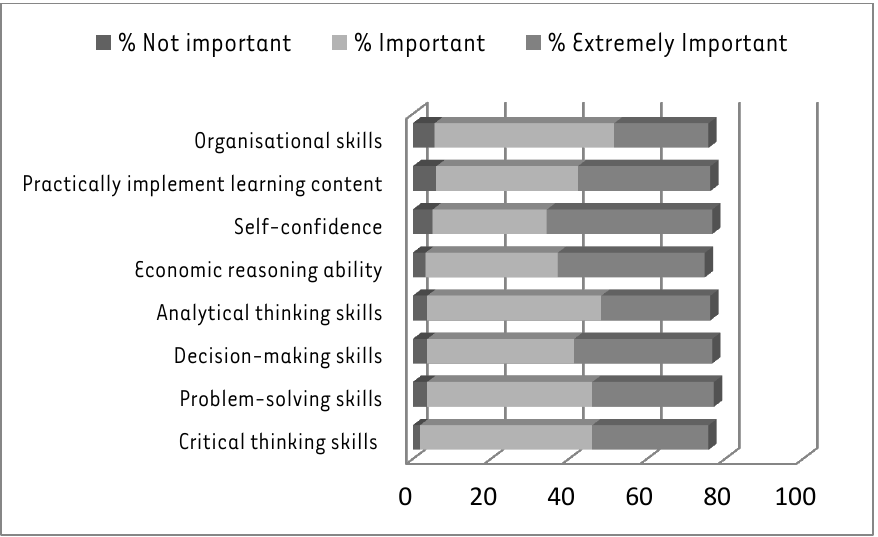
FIGURE 1: Most important skills required for B.Com (Finance)